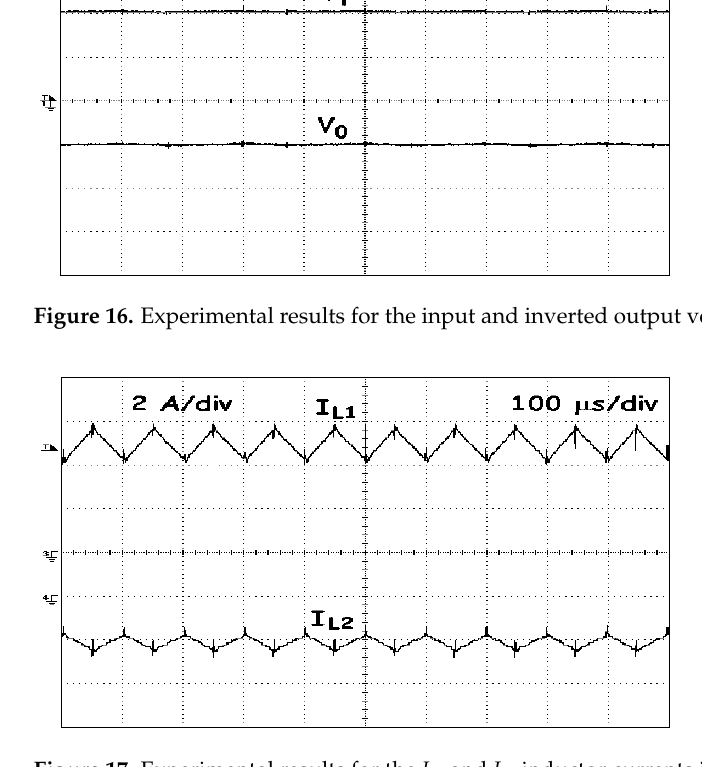
Figure 18. Experimental results for the voltage across the power switch S W and the diode D 1 in buck mode.